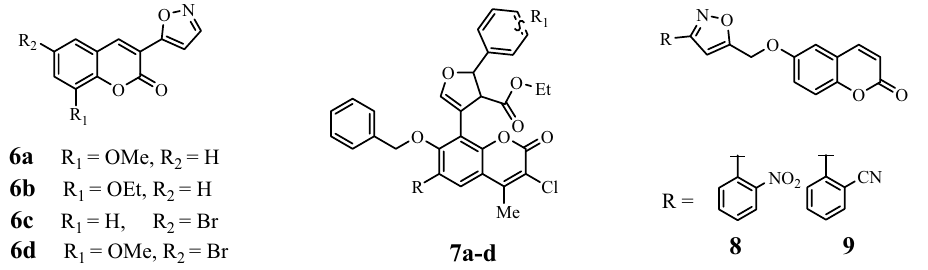
Figure 3. Structure of biologically active coumarin-isoxazole